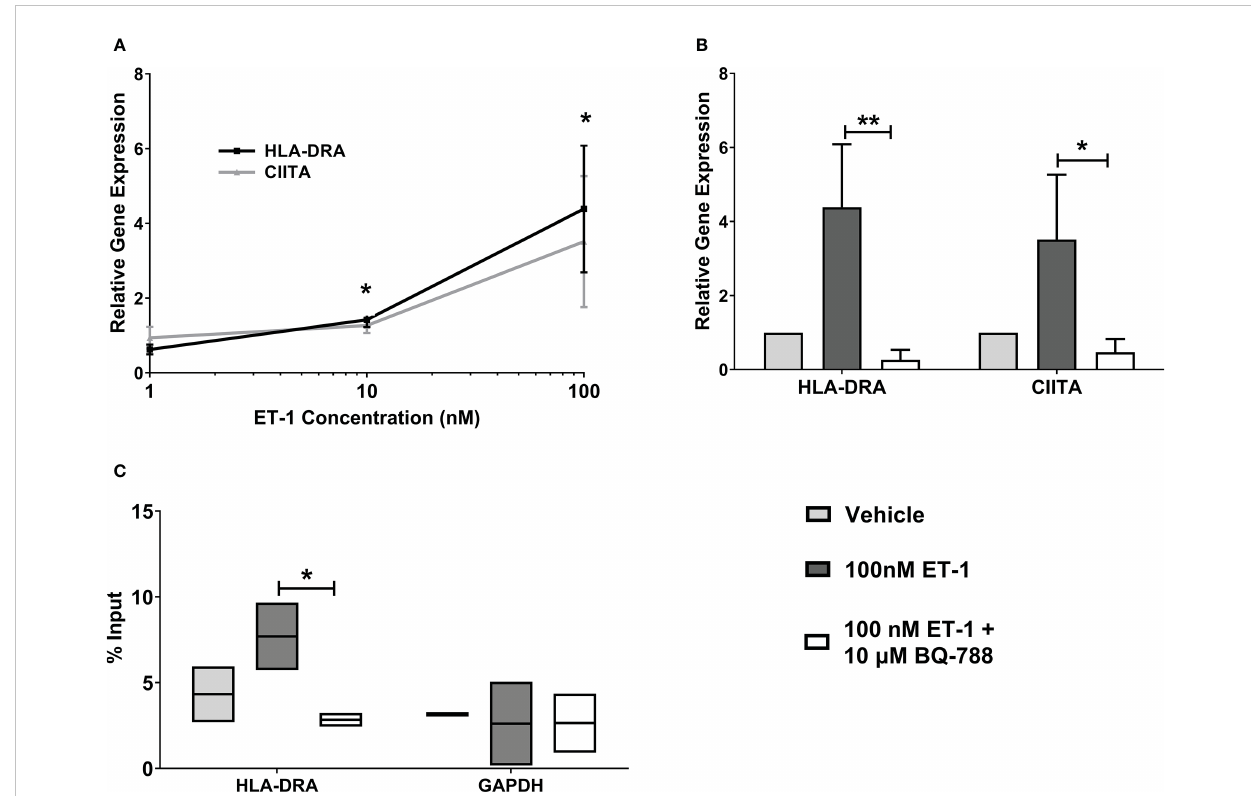
FIGURE 2 Increased MHC class II expression by ET-1 incubation in vitro . (A) EA.hy926 endothelial cells were incubated with 1, 10, and 100 nM ET-1. (B) EA.hy926 cells were incubated with 100nM ET-1 (dark grey bar) or preincubated with 10µM BQ788, a selective blocker of ET-1 type B receptors (white bar) for 24 h at 37°C and compared to vehicle treatment (light grey bar). Gene expression was quanti fi ed by qRT-PCR using TaqMan probes. (C) CIITA Chromatin Immunoprecipitation. CIITA is associated with MHC class II promoter in EA.hy926 cells treated with 100 nM ET-1 for 24 hours at 37°C. Lysates were immunoprecipitated with antibodies against CIITA, and DNA was isolated and analyzed by real-time PCR. Values were normalized to the total amount of promoter DNA added to the reaction (input). Input = 5% of total cell lysate. Data represent mean ± SD (n = 3). *p < 0.05, **p < 0.01, 100nM ET-1 versus 100nM ET-1 with 10µM